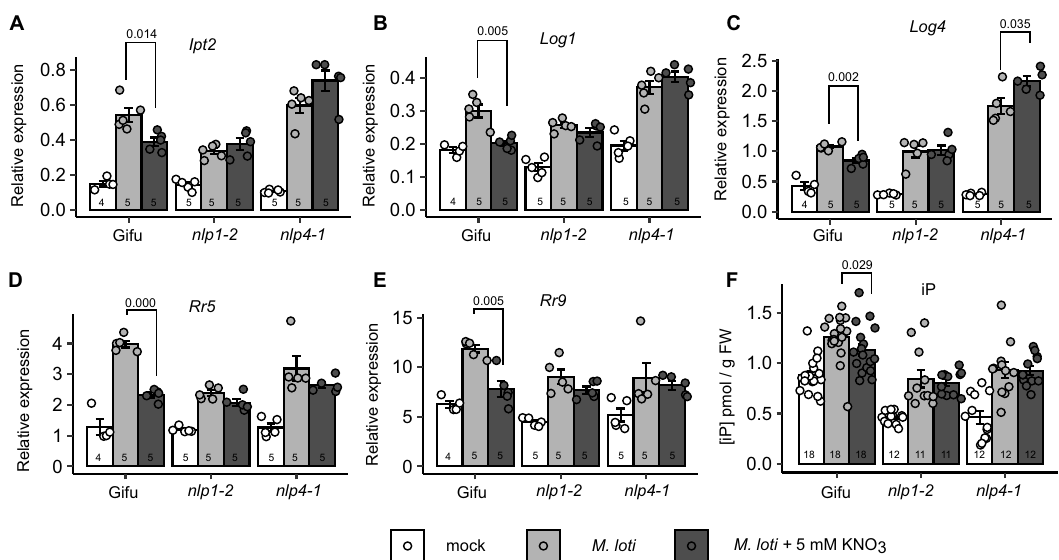
Fig. 6 Nitrate restriction of cytokinin biosynthesis and signalling requires Nlp1 and Nlp4 . Relative transcript abundance of Ipt2 ( A ), Log1 ( B ), Log4 ( C ), RR5 ( D ) and RR9 ( E ) by qRT-PCR 1 dpi with M. loti in the absence and presence of 5 mM KNO 3 in the indicated genotypes. Ubiquitin is used as a reference gene. F Cytokinin iP free base content in the indicated genotypes at 2 dpi with M. loti . Bars show mean ± SE for the indicated n values. Signi fi cant differences between nitrate presence and absence conditions is indicated with annotated P values as determined by Student ’ s t test in A – E and Wilcoxon rank-sum test in F